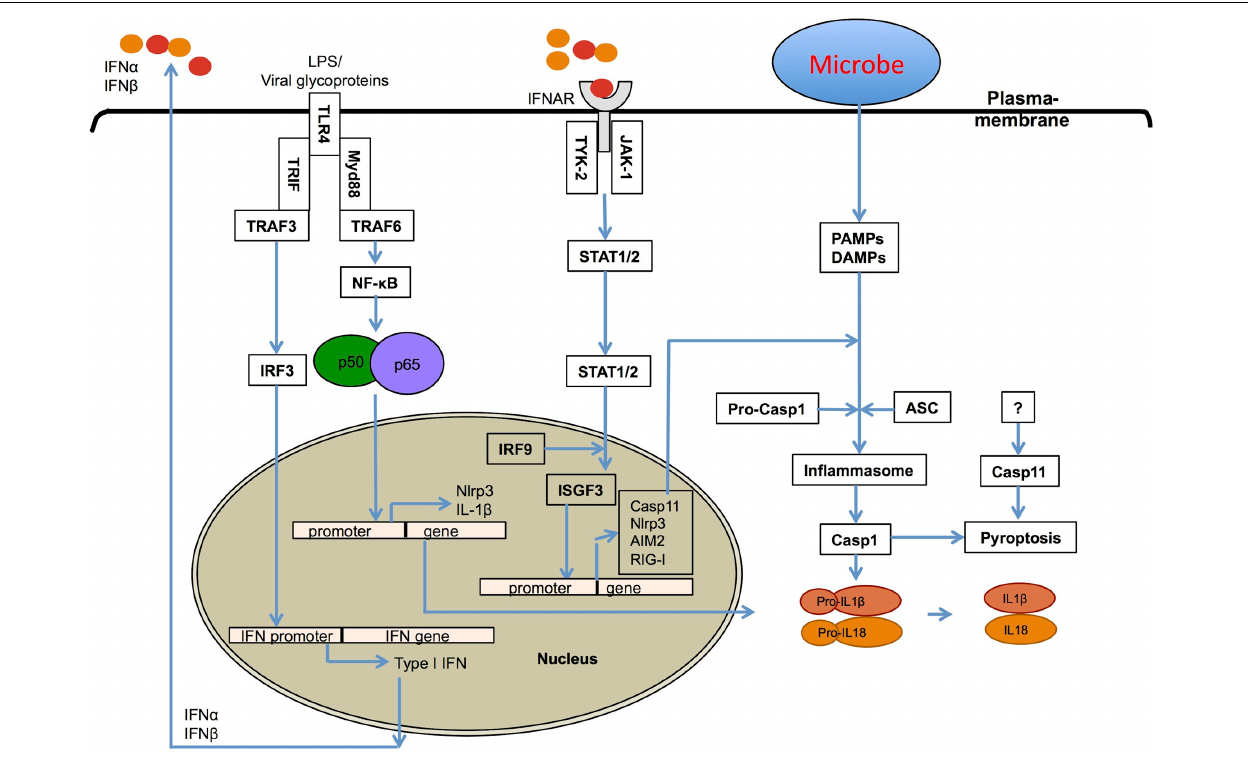
FIGURE 2 | Role of type I interferons in inflammasome activation. Type I IFNs contribute to inflammasome activation through two different mechanisms. First, type I interferons are required for the upregulation of caspase-11, which contributes to activation of a non-canonical NLRP3